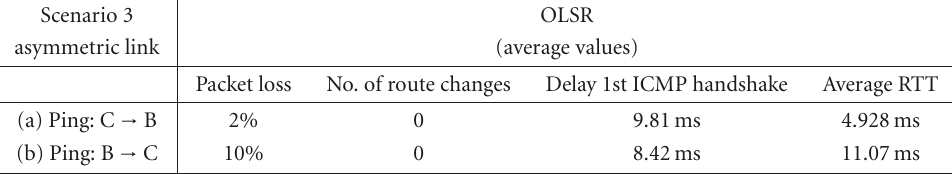
Figure 12: Asymmetric links: OLSR performance on scenario